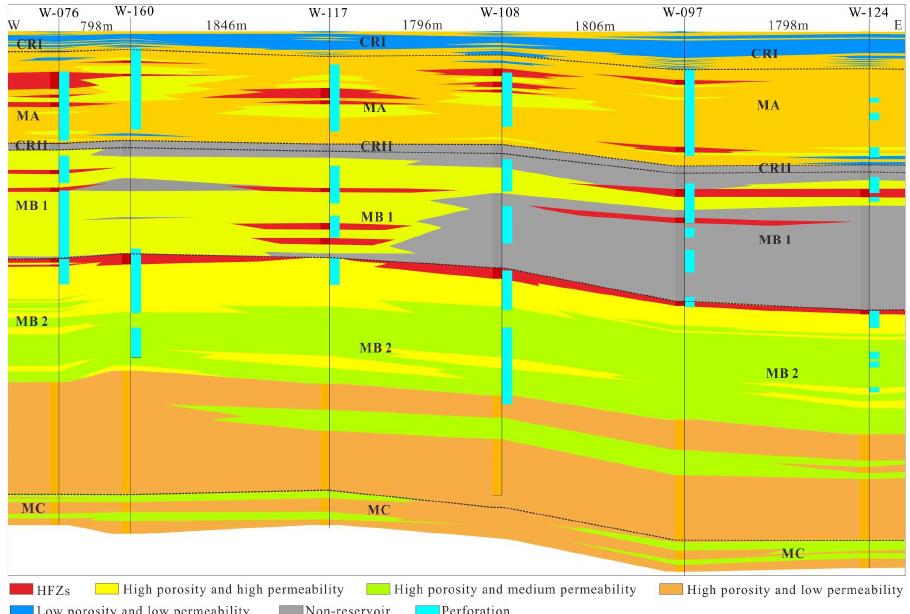
Figure 4. Vertical heterogeneity in the Mishrif Formation in X Oilfield.